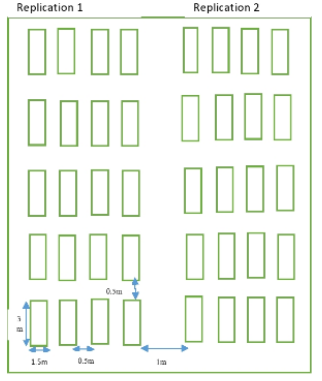
Figure 2: Field layout of the experimental field in an alpha lattice